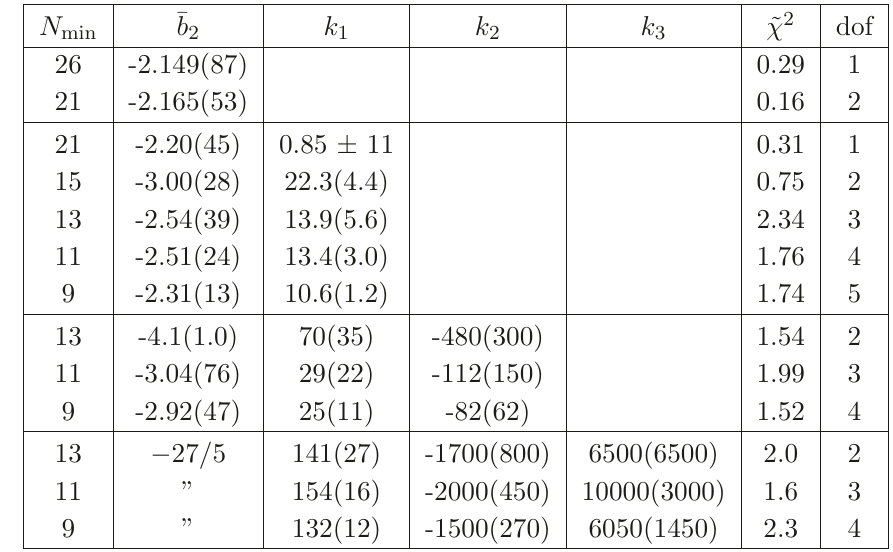
Table 4 . In this table we report systematics for the determination of the large- N behavior of b